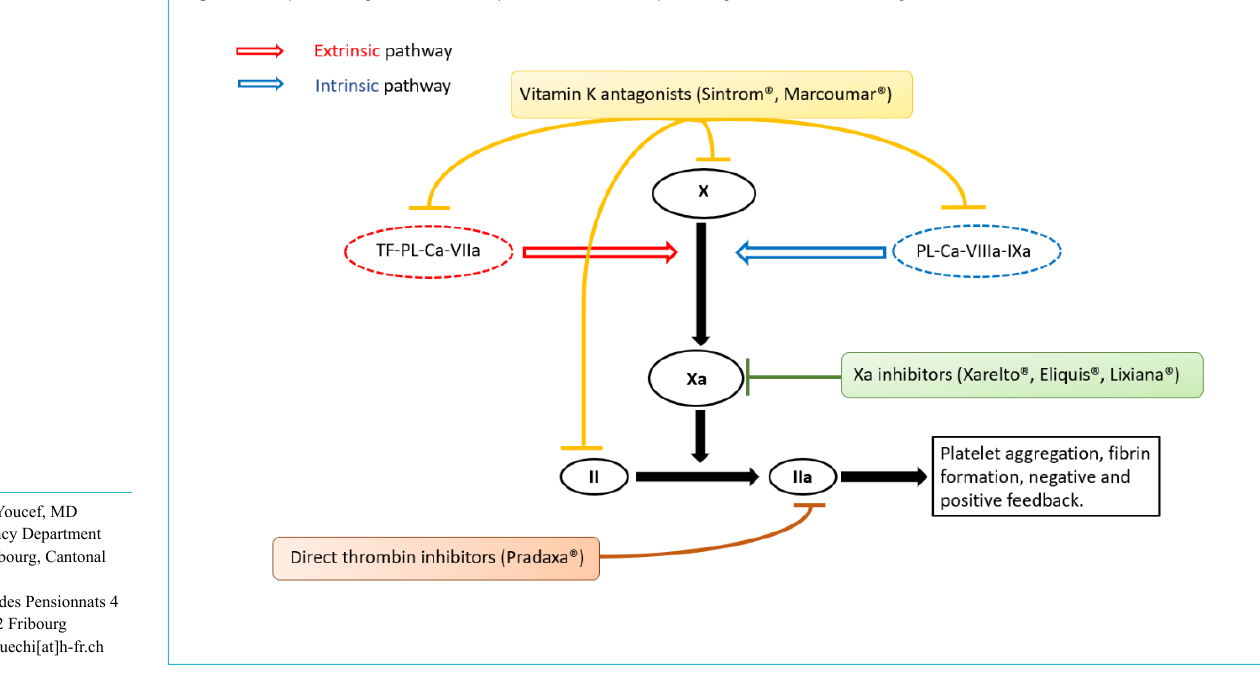
Figure 1: Simplified coagulation cascade (extrinsic and intrinsic) with targets of different